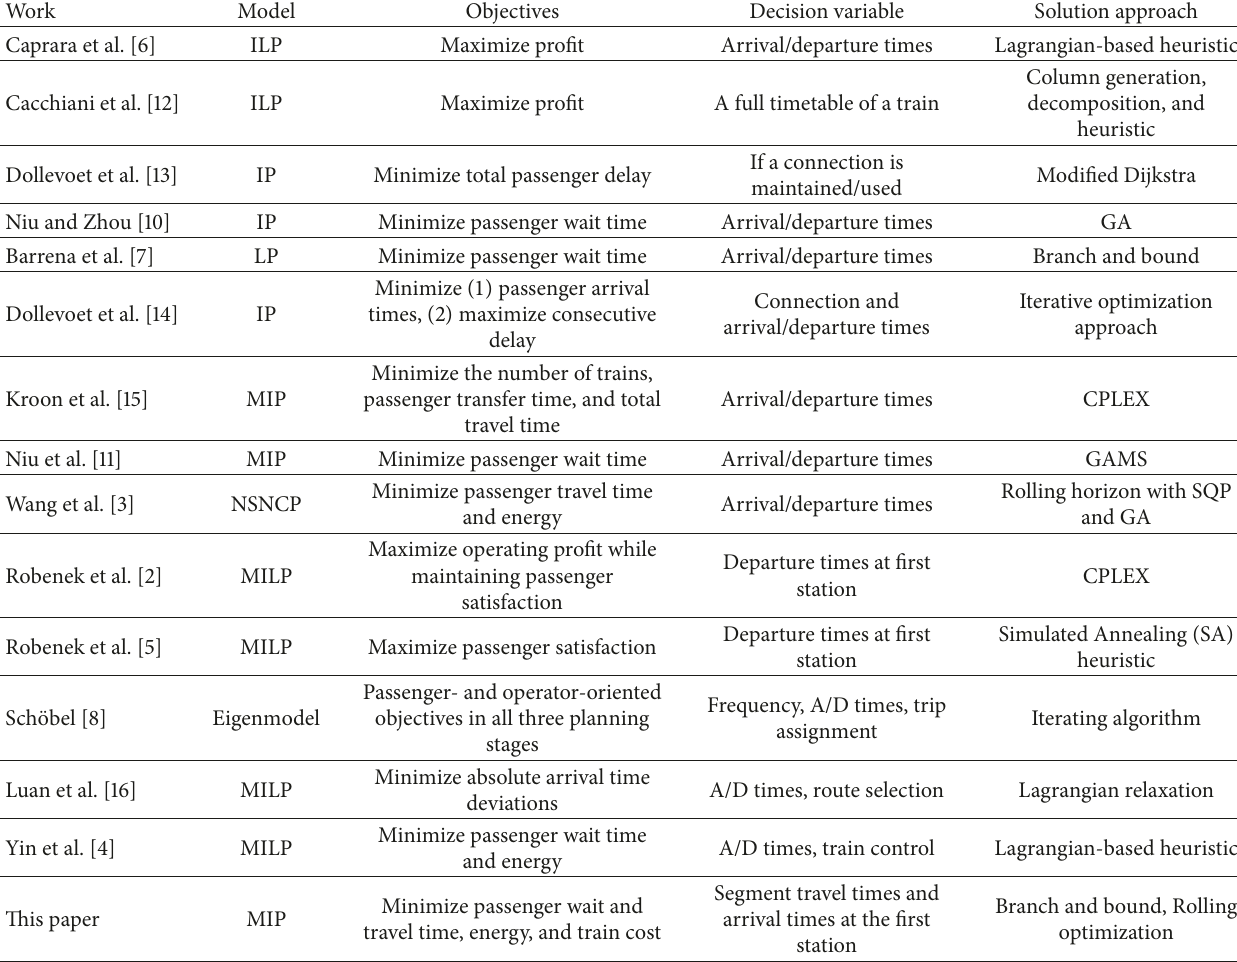
Table 1: Summary of publications related to the